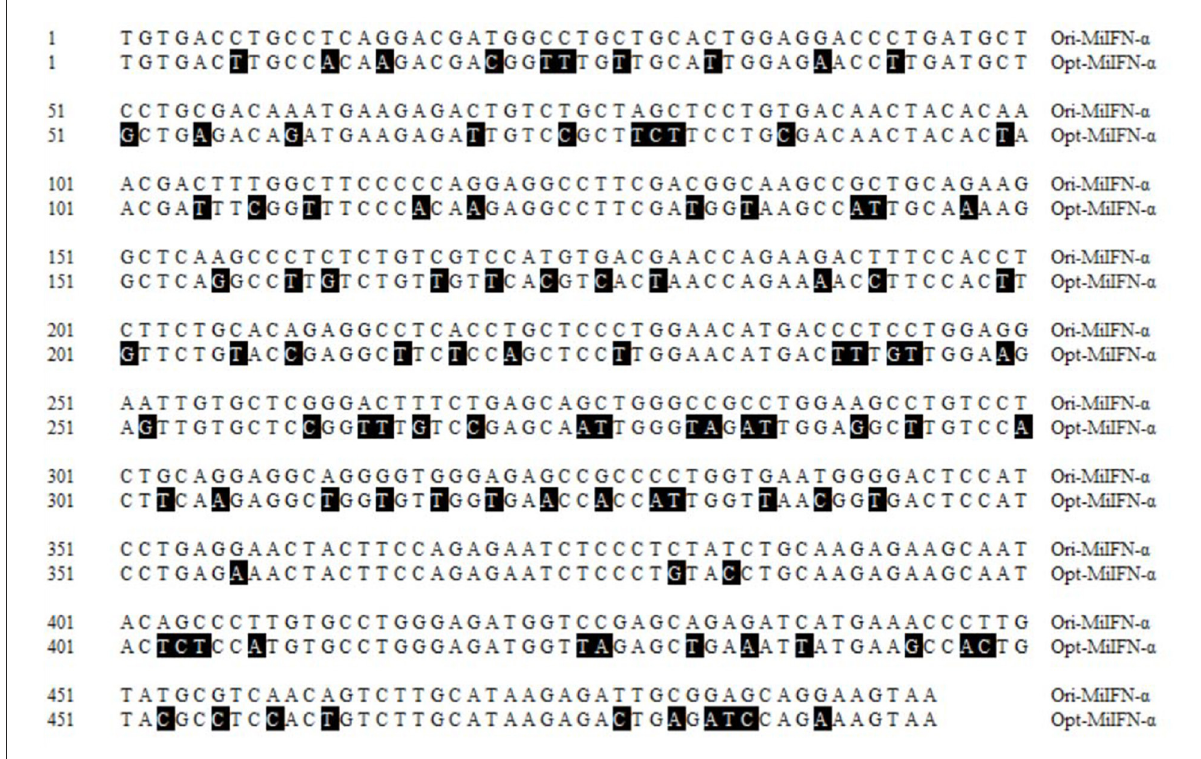
FIGURE2 Nucleotide alignment between the original and optimized sequences. Nucleotide homology between the optimized and original sequences reached 74.8%. Black areas indicate differences in nucleotides.